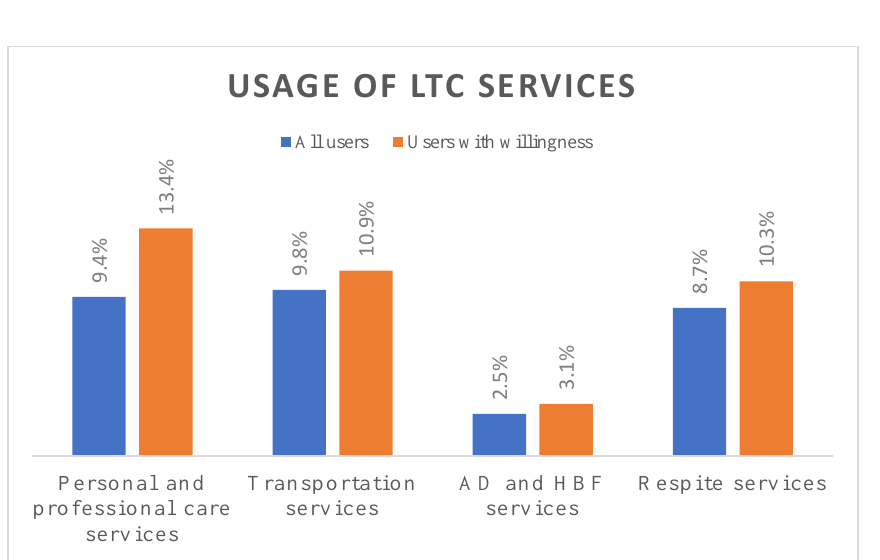
Figure 1. Percentages of “all users” and “users with willingness” by the four LTC services used. (AD: Assistive devices; HBF: home barrier-free).